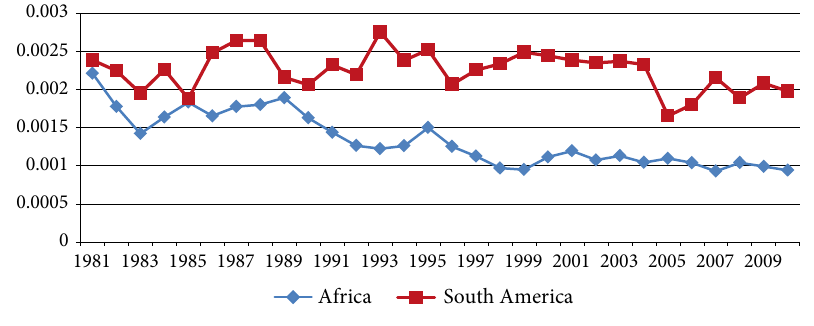
Fig. 3. Knowledge gap of African and South American countries with respect to the US Note : see Table